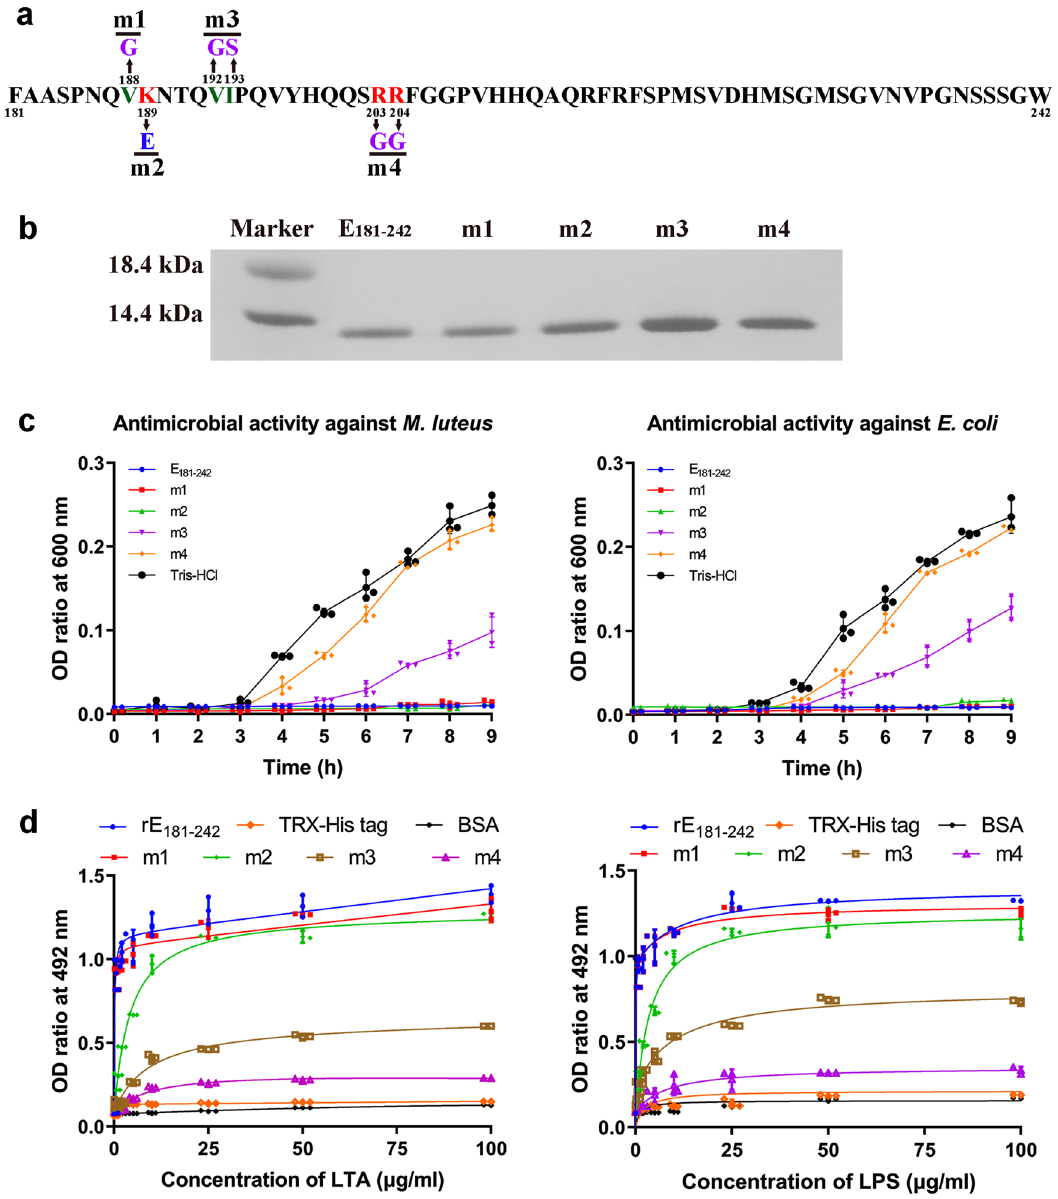
Fig. 8 Antibacterial activity of rE 181 – 242 mutants. a Diagram showing the site-directed mutagenesis. b SDS-PAGE of the mutants, showing that they all have a similar molecular mass. c Antibacterial activities of rE 181 – 242 mutants against M. luteus and E. coli . rE 181 – 242 was used as positive control and Tris-HCl buffer used as negative control. d Interaction of E 1 – 180 mutants with LTA and LPS revealed by ELISA. Each point in the graph represents the mean ± SD ( n = 3). The data are from three independent experiments performed in triplicate. The bars represent the mean ± Methods Fish and embryos . All the fi sh used were treated in accordance with the guidelines of the Laboratory Animal Administration Law of China with the permit number